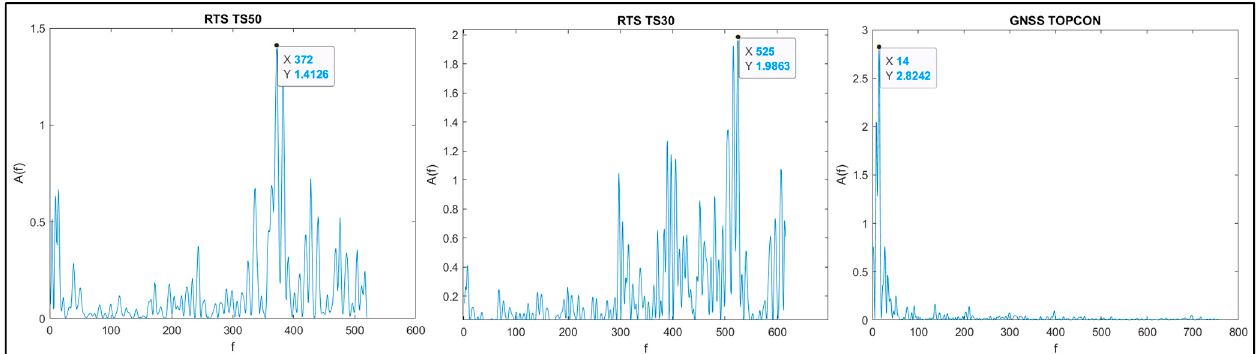
Figure 5. Lomb–Scargle periodogram for the frequency range between 0 and 1 Hz.